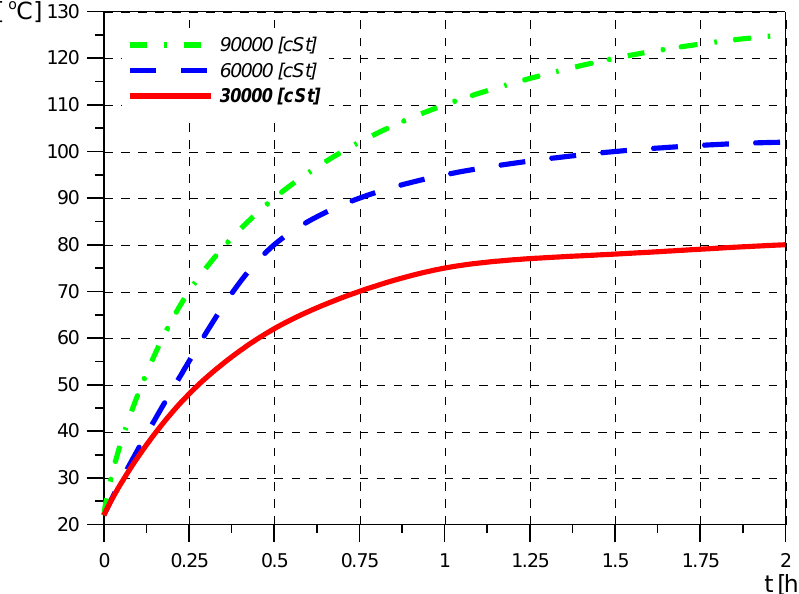
Figure 9. Temperature changes of a damper filled with liquids of different viscosities as a function of time.